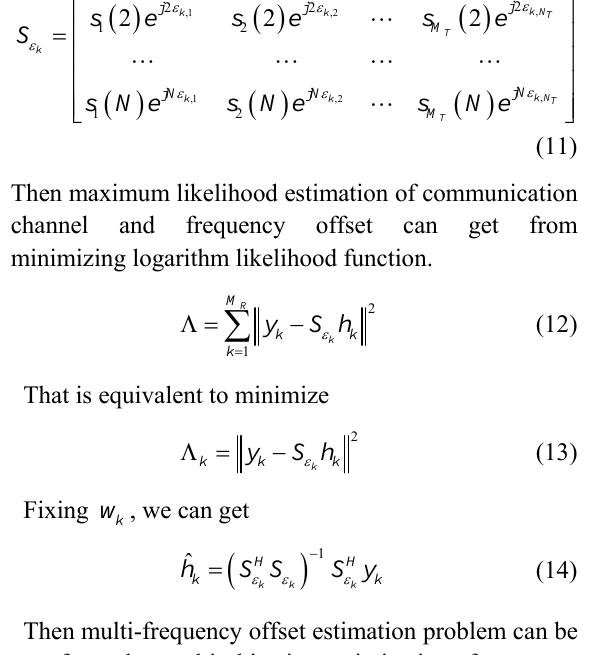
algorithm to accelerating algorithm ECM and simplified multi-dimensional search effort to estimate multi- frequency offset using SAGE, the mean square error of estimation approached